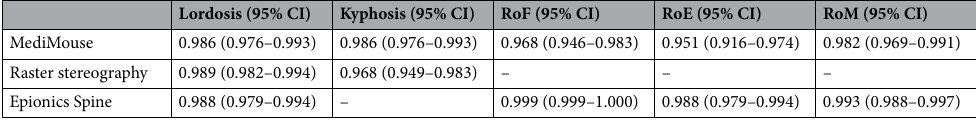
Table 1. Intraclass correlation (ICC) between the five single measurements of each device for the investigated parameters. CI confidence interval, RoM range of motion, RoF range of flexion, RoE range of extension.